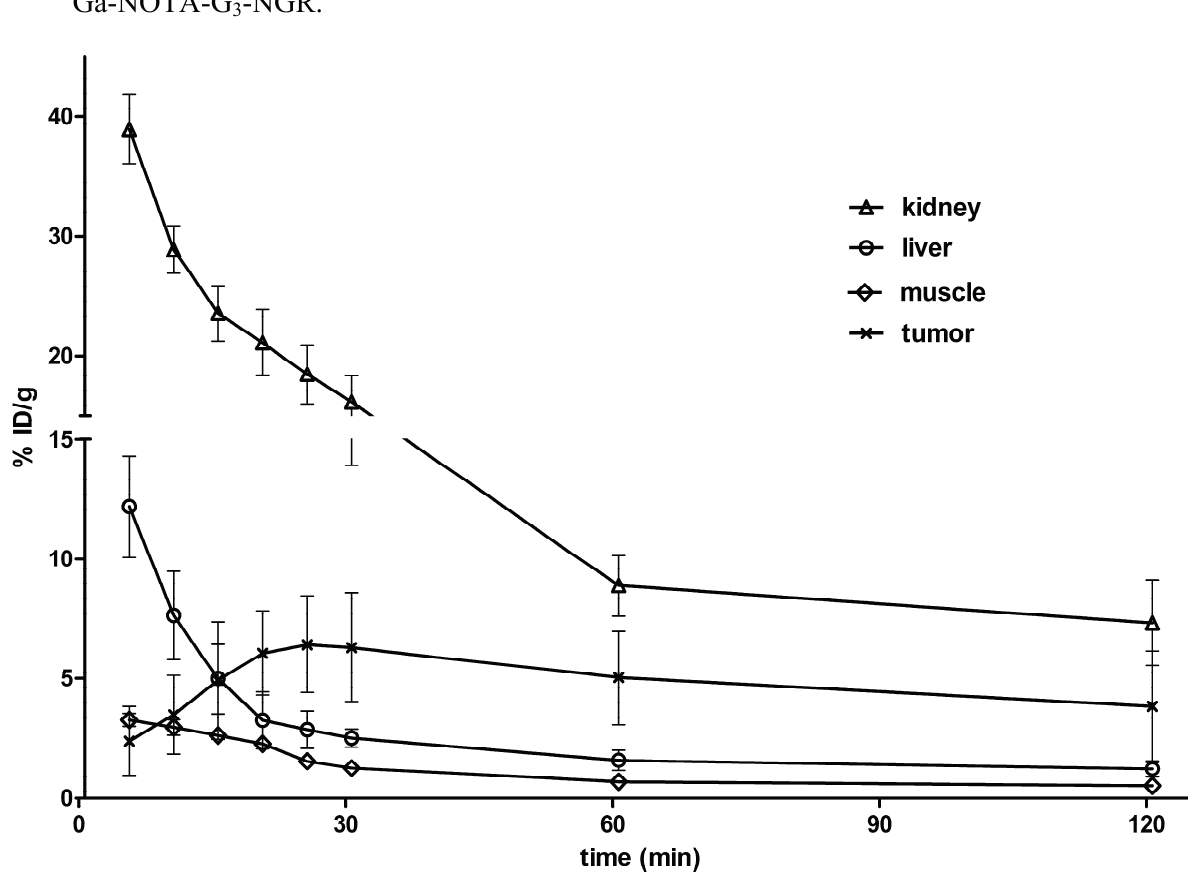
Figure 3. Time-activity curves from quantitative microPET imaging analysis of 68 Ga-NOTA-G 3